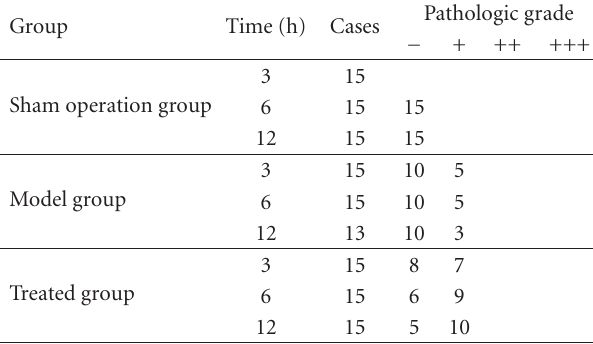
Table 6: Expression of Caspase-3 protein of the thymus. Group